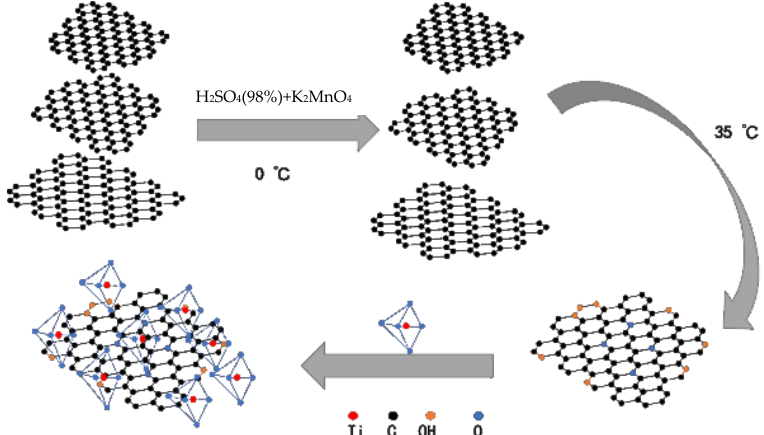
Figure 1. Preparation flow chart of modified TiO 2 photocatalyst material.